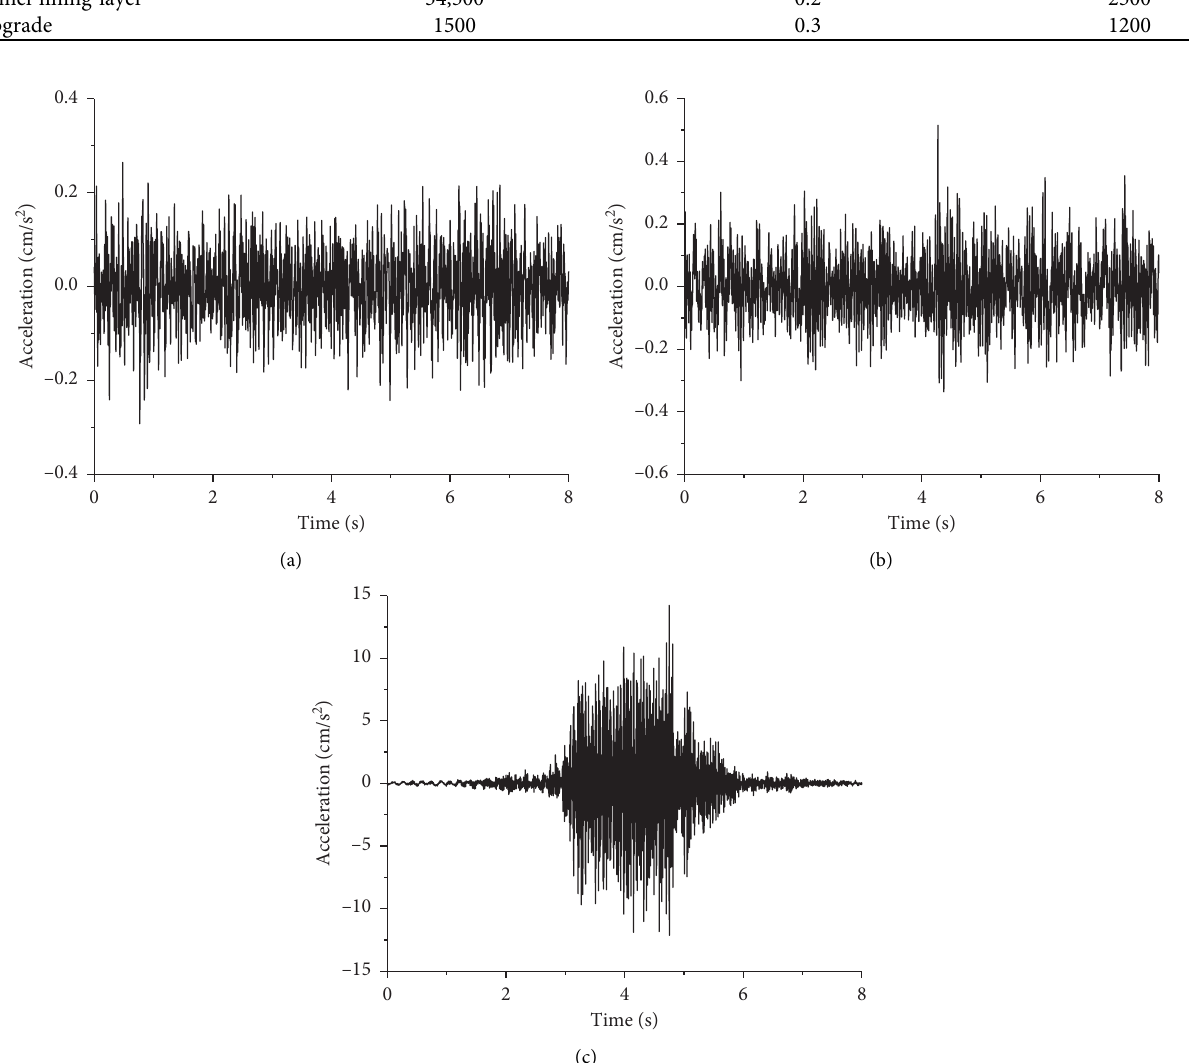
Figure 27: Acceleration time-history curves of vibration source: (a) Luoshan Road traffic, (b) Luoshan Road viaduct traffic, and (c) maglev.